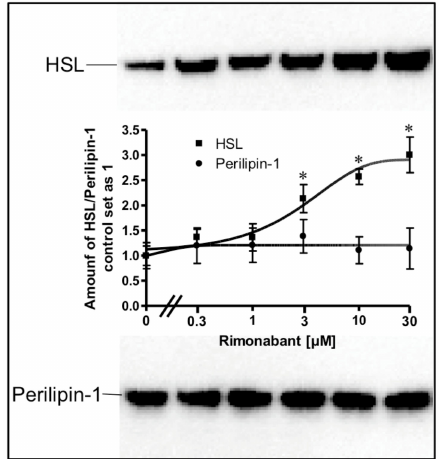
Figure 9. Increase in the amount of LD-associated HSL in a cell-free system by Rimonabant. Primary rat adipocytes were incubated (20 min, 37 ◦ C) in the absence or presence of increasing concentrations of Rimonabant. Subsequently, LD were prepared from the washed adipocytes, reconstituted with partially purified rat adipocyte HSL and then incubated (90 min, 30 ◦ C). LD were recovered from the total incubation mixtures by centrifugation through a sucrose cushion from the top fraction 6 (see Materials and Methods). Extracted proteins were separated by SDS-PAGE and analyzed for HSL ( (cid:4) ) and perilipin-1 ( • ) by immunoblotting. The images of a typical experiment are shown repeated two times with similar results. The quantitative evaluation of the three experiments is also shown (mean ± SD). * p ≤ 0.05 for HSL recovered with LD between absence and presence of Rimonabant; no significant di ff erences for